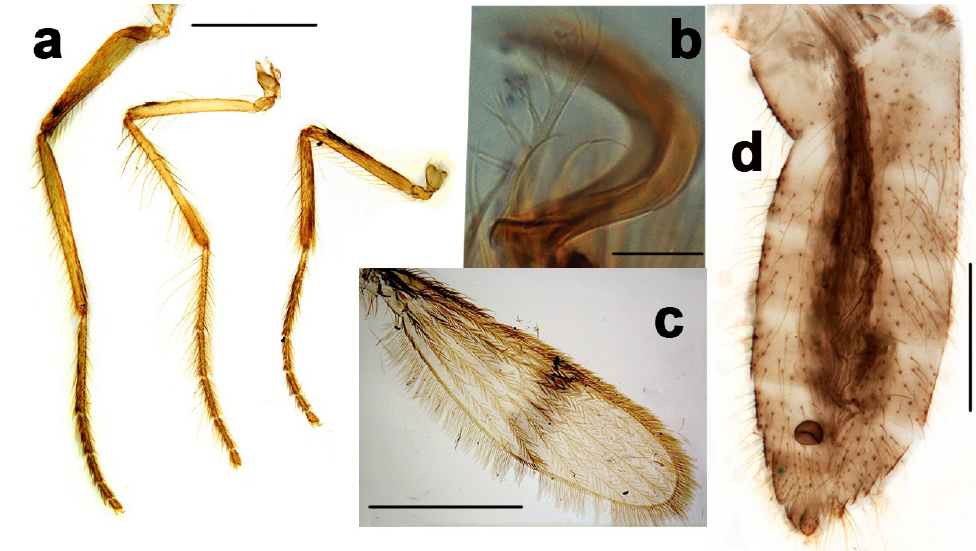
Fig. 6. Microphotography of Corethrella ielemdei Feijó, Ramires, Lima & Pessoa sp. nov. ♀, ( ILMD 000 - 51). a . Legs. b . Tarsal claw with empodium. c . Wings. d . Abdomen. Scale bars: a = 100 μm; b = 10 μm; c–d = 500